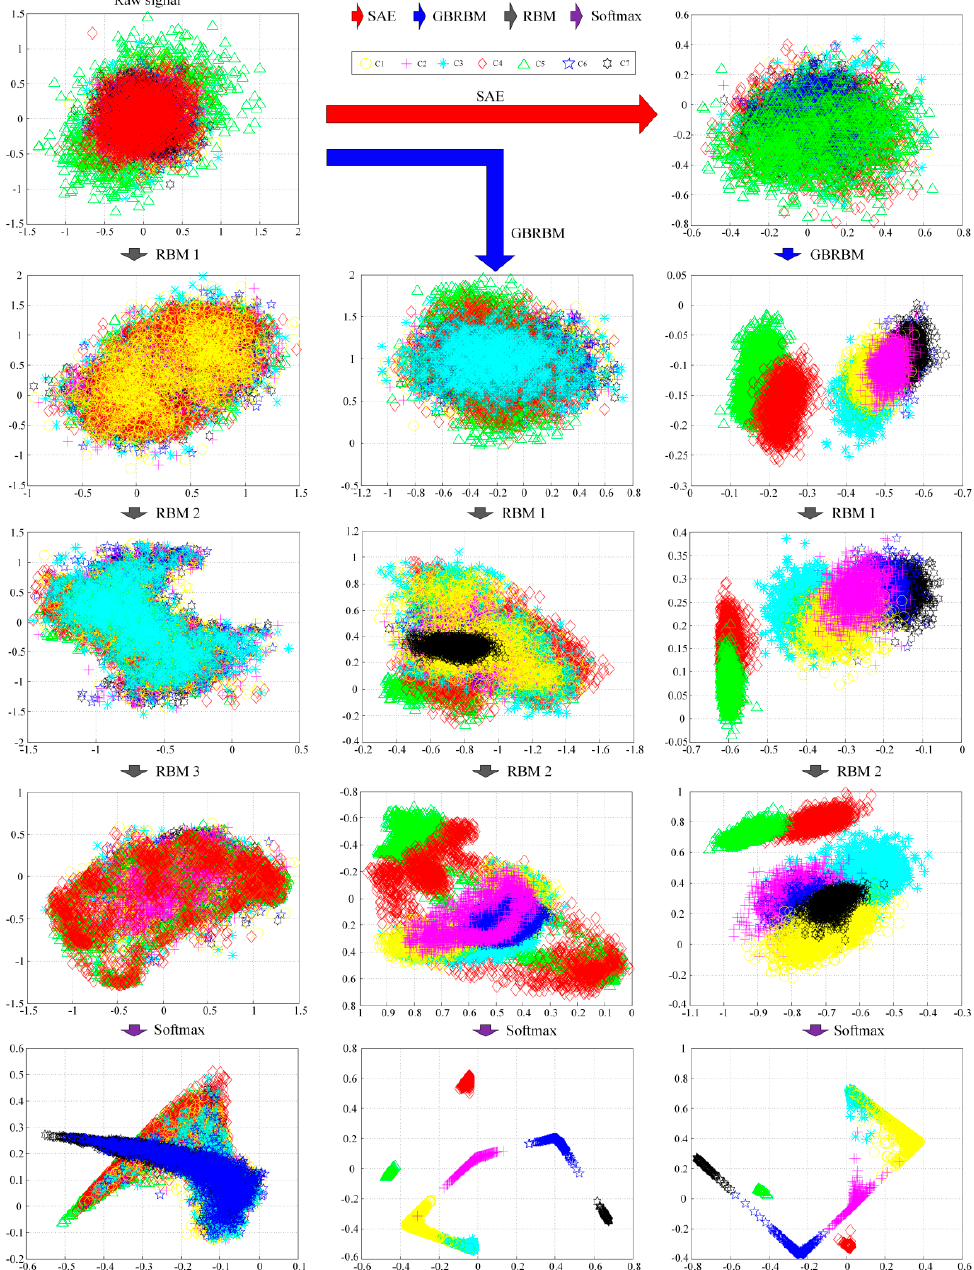
Figure 4. Each layer PCA result of three methods.